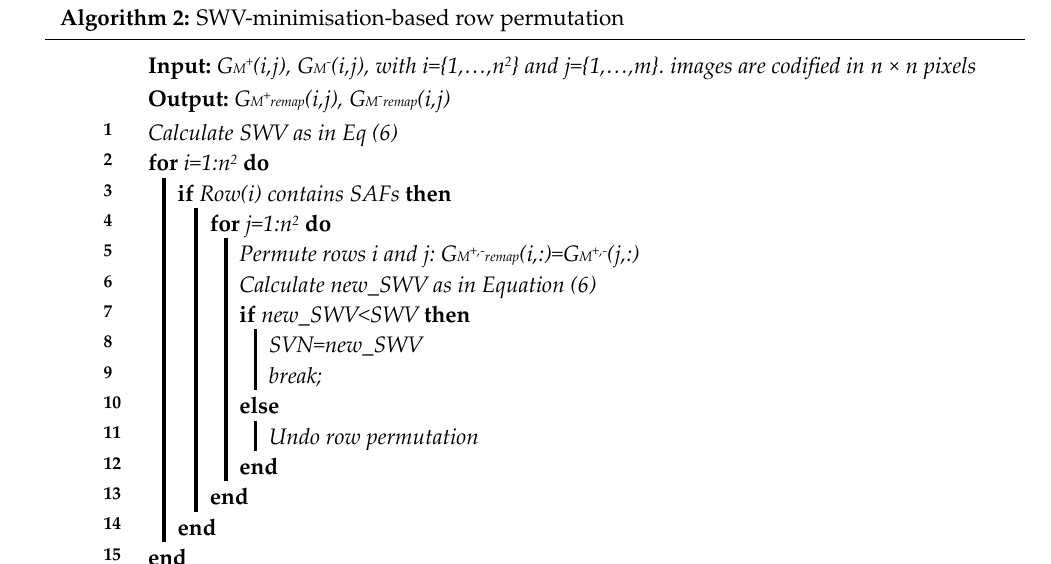
Algorithm 2: SWV-minimisation-based row permutation